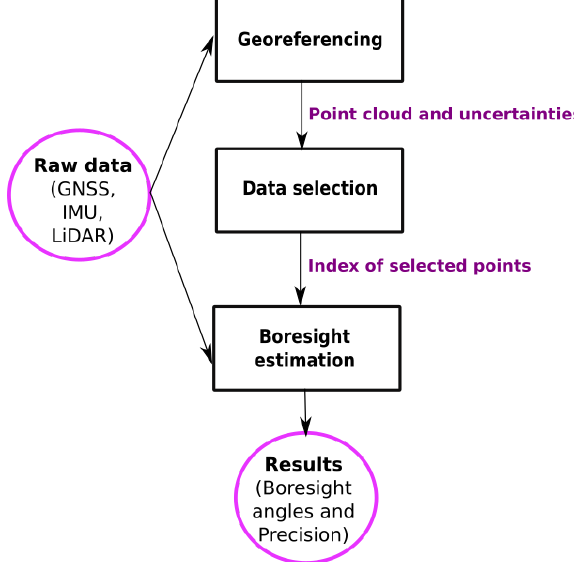
Figure 4. Three modules of LiDAR IMU boresight automatic calibration (LIBAC): the georeferencing, the data selection and the boresight estimation. The data selection needs the georeferencing to be performed first. The boresight estimation needs the data selection to be done, in order to decompose the point cloud in different planar